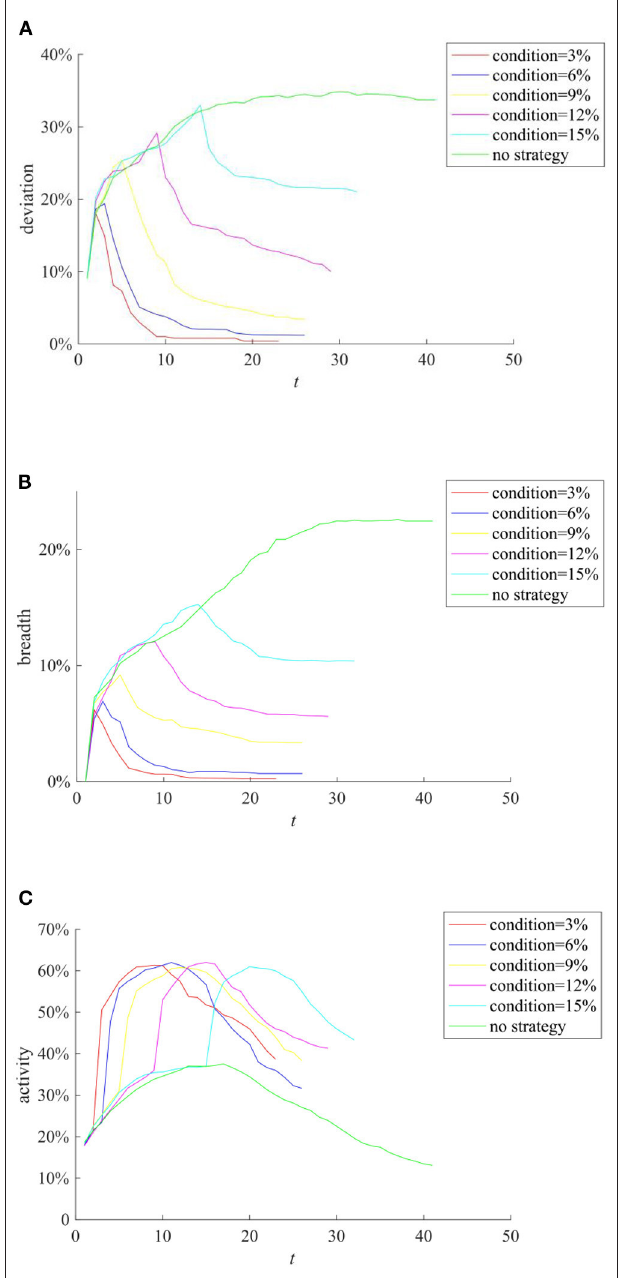
FIGURE 14 | The influence of the time moment on the effect of rumor refuting strategy. (A) Entire network information content deviation. (B) Rumor diffusion range. (C) Network